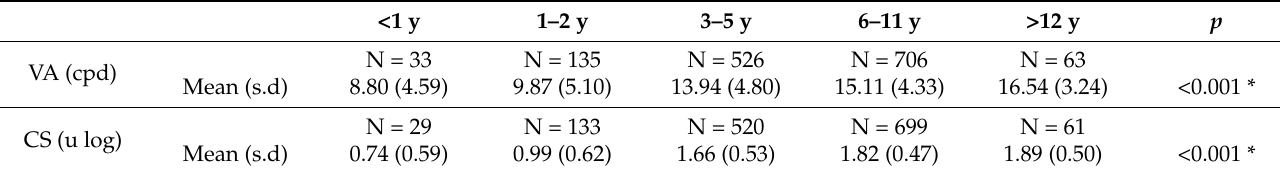
Table 2. AV and CS results in the Norm group, according to age groups.